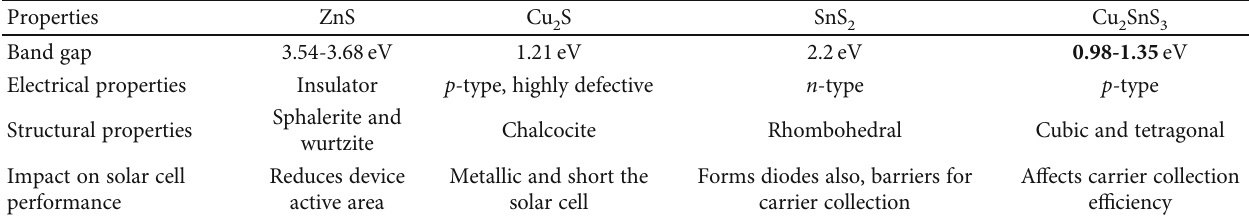
Table 1: Various properties of secondary phases observed in CZTS